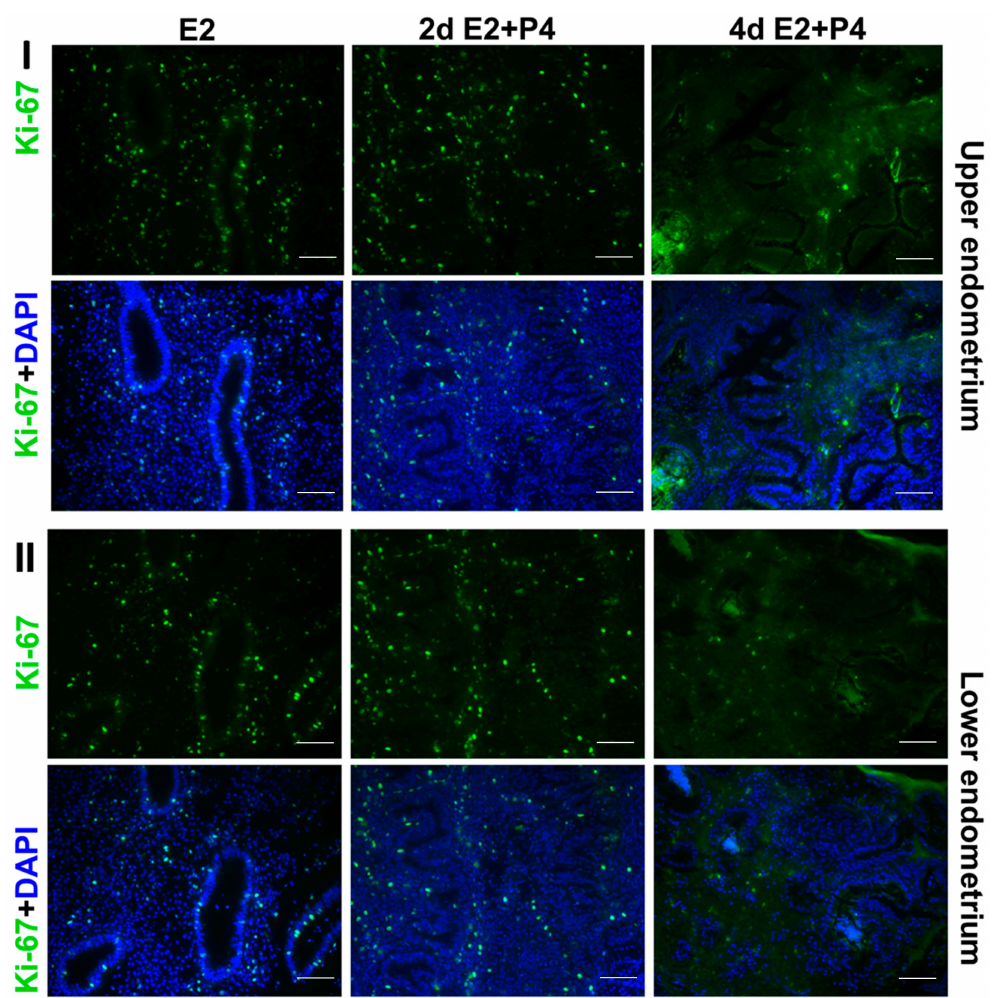
Figure 4. Ki-67 expression (proliferation marker) in the upper (I) and lower (II) zones of full thickness endometrial slices in culture. Four days of P4 alone (data not shown) or E + P4 treatments markedly suppress Ki-67 expression. Scale bar 200 µ m; Original magnification 160 ×